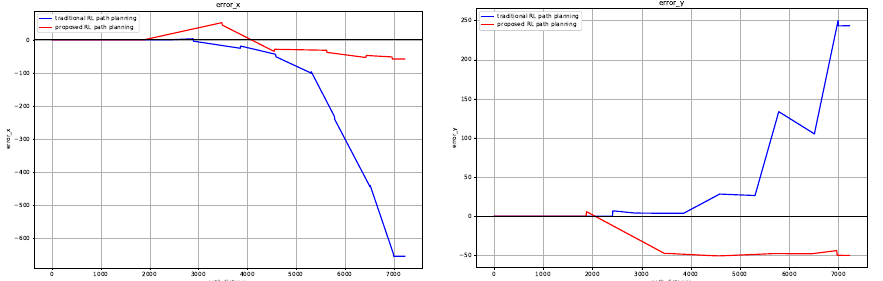
Figure 6. Cumulative error of two algorithms in x and y directions.